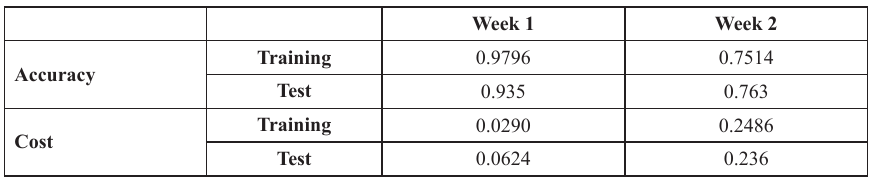
Table 7. Training/test